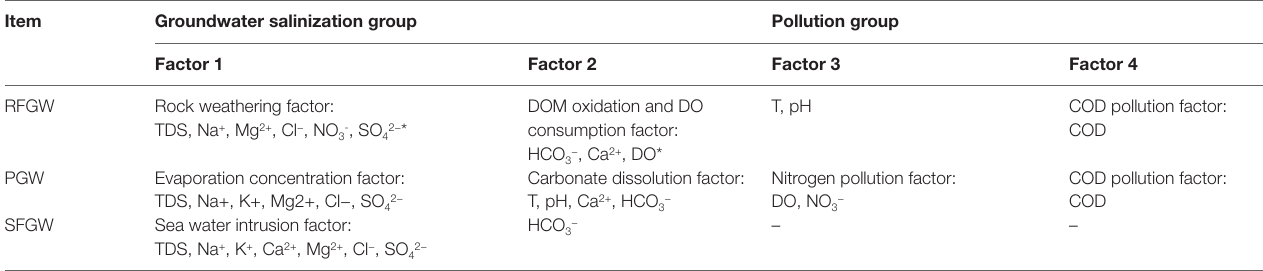
TABLE 1 | Results of factors analysis in the different